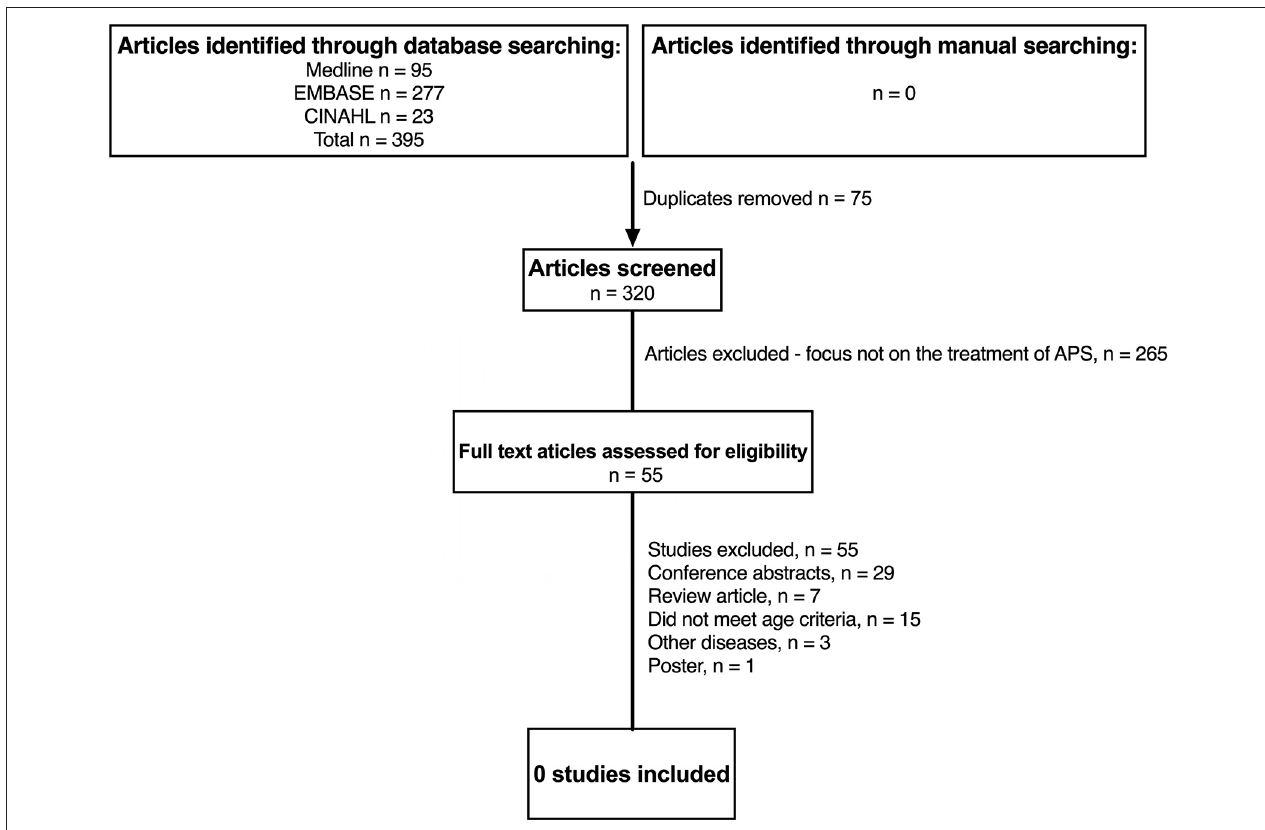
FIGURE 2 | Identification of studies evaluating treatment of childhood antiphospholipid syndrome since 2012. N, number of patients; APS, anti-phospholipid syndrome; JSLE, Juvenile Systemic Lupus Erythematosus; SLE, Systemic Lupus Erythematosus.